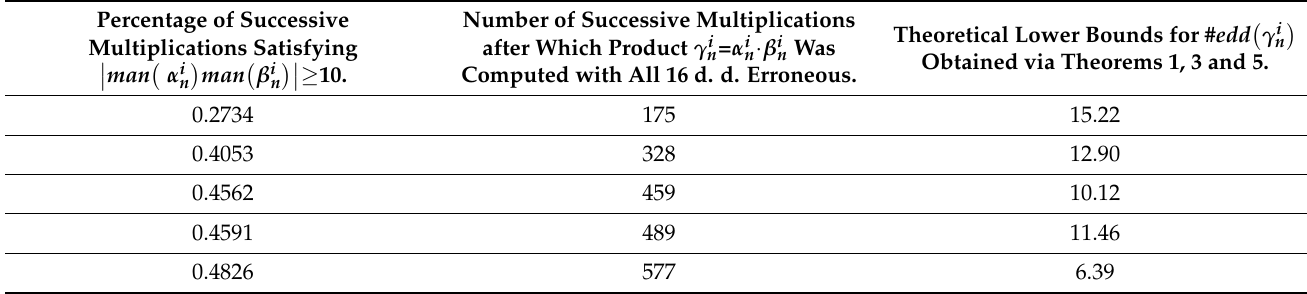
(cid:12) (cid:17)(cid:12) (cid:16) (cid:17) (cid:16) (cid:12) (cid:12) ≥ 10. man α i n β i n (cid:12) man (cid:12)